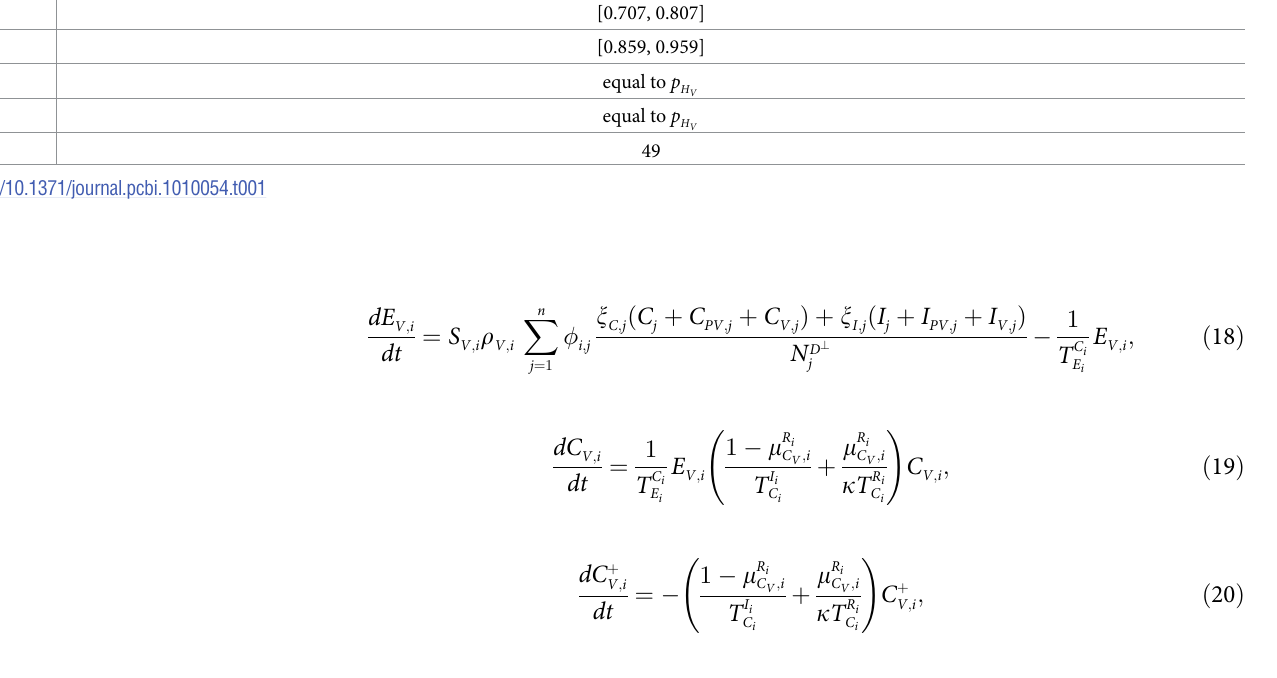
range in age group